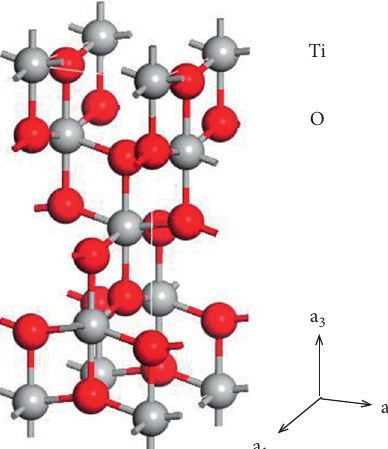
Figure 1: Schematical picture of crystal geometry and basis vector direction for anatase TiO 2 in which the red sphere represents oxygen and the gray sphere represents